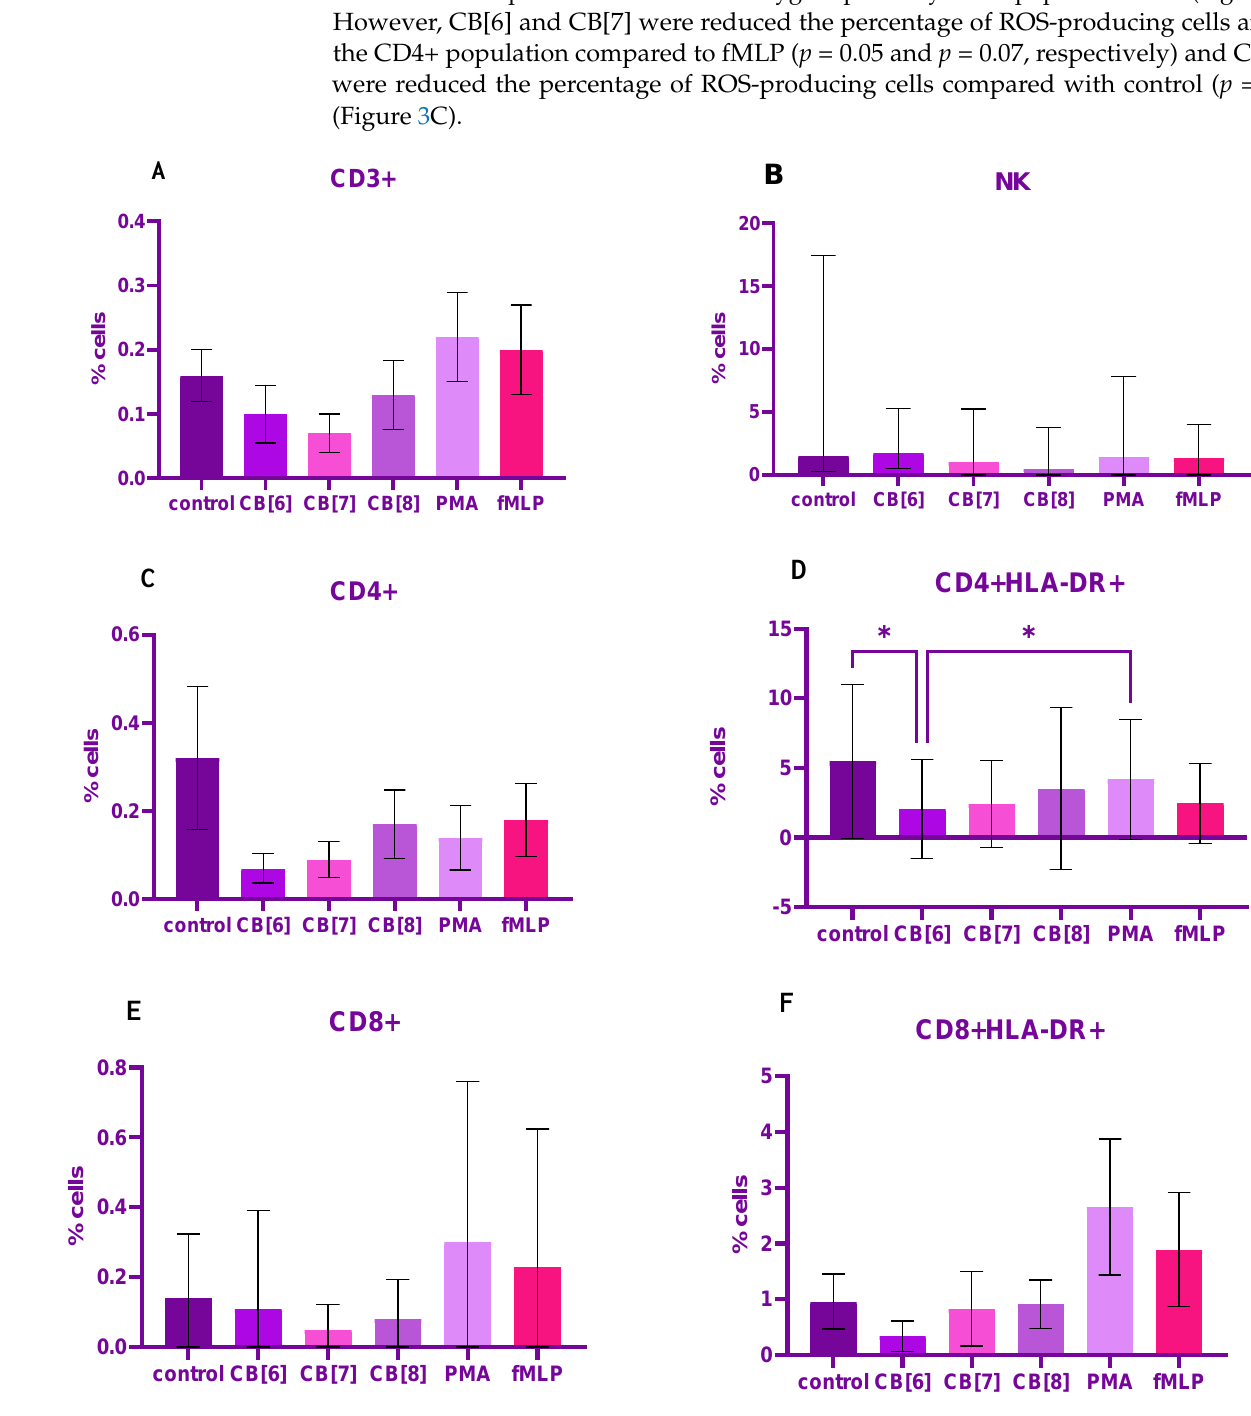
H Figure 3. Cont